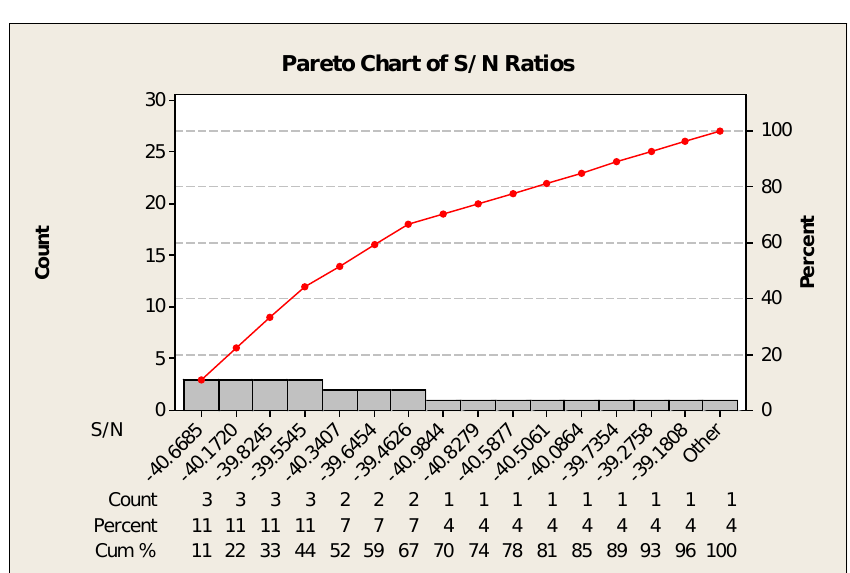
Fig. 2. Pareto Chart of S/N